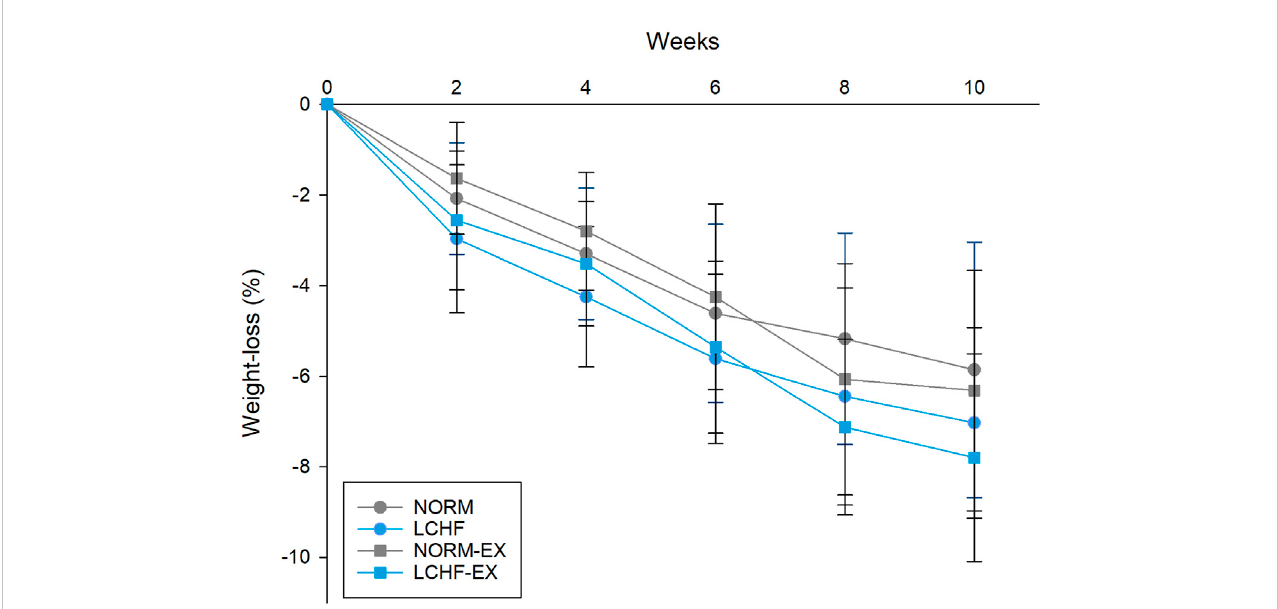
FIGURE 2 Weight loss during the intervention, measured every 2 weeks. Data are presented as mean ± standard deviation (SD). NORM, Normal diet; LCHF, Low- carbohydrate high-fat diet; NORM-EX, Normal diet combined with exercise; LCHF-EX, Low-carbohydrate high-fat diet combined with exercise.